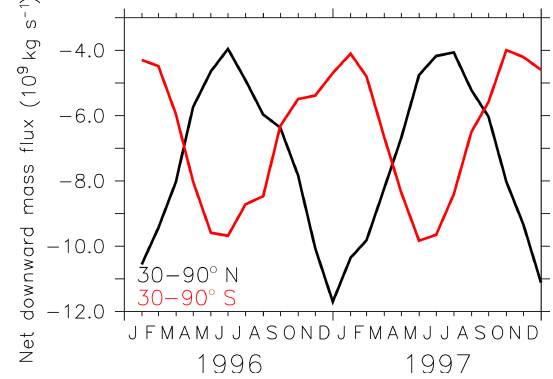
Figure 15. Monthly net mass fluxes from the LG(diab) simulation through the 380K isentrope for the northern and southern extratrop-